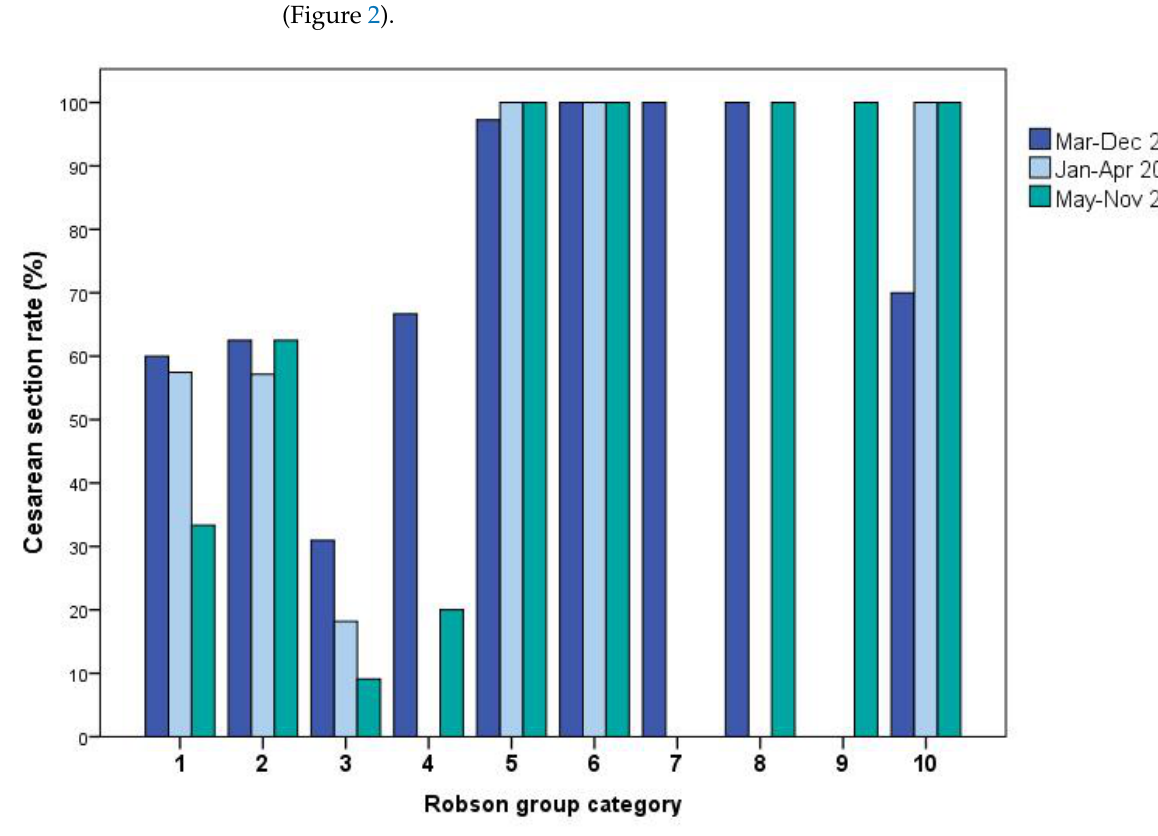
Figure 2. Caesarean section rate of included COVID-19 pregnancies according to the Robson group category and the time period. Missing columns for groups 7 and 9 are referred to absence of cases in the